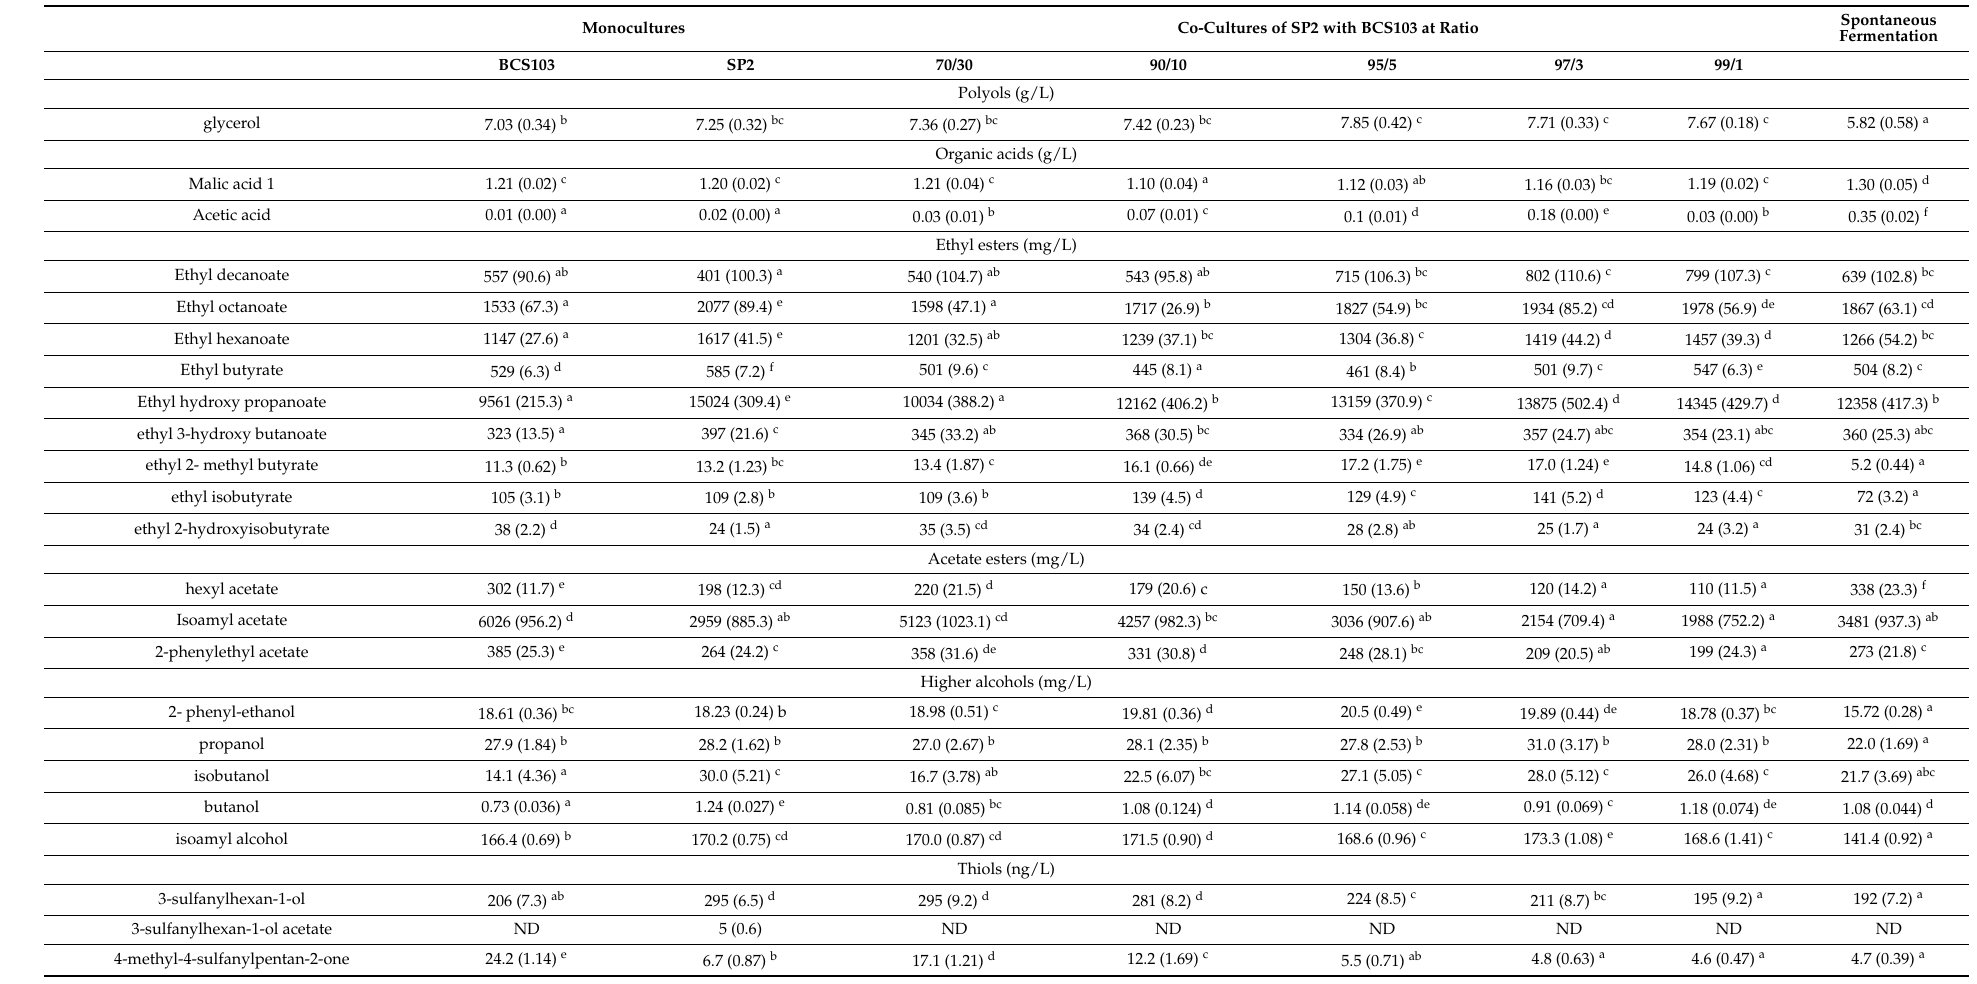
Table 4. Volatile and non-volatile compounds at the end of alcoholic fermentation of Sauvignon Blanc